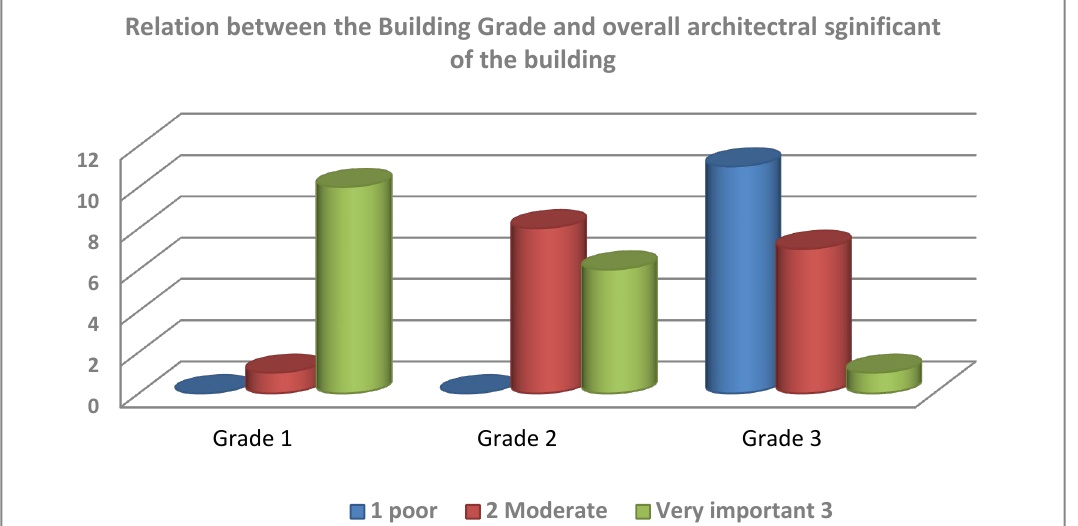
Figure 10. Relation between the building grade and overall architectural significance of buildings.